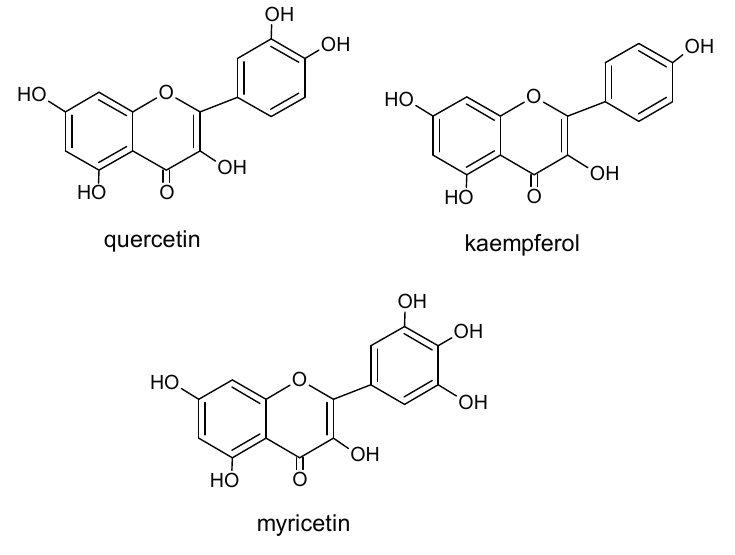
Figure 4. The structure of selected